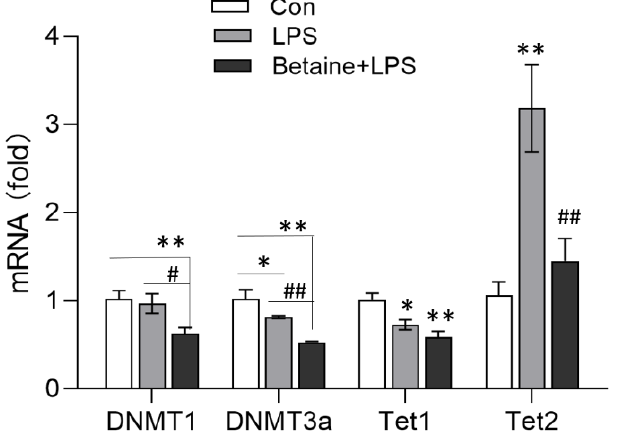
Figure 3. qRT-PCR quantification of the mRNA expression of DNA methylation-associated en- zymes. The treatment and method were described in Figure 1 caption. Values are mean ± SEM, n = 6/group. Significance levels: * p < 0.05, ** p < 0.01 vs. control, # p < 0.05, ## p < 0.01 vs. LPS.